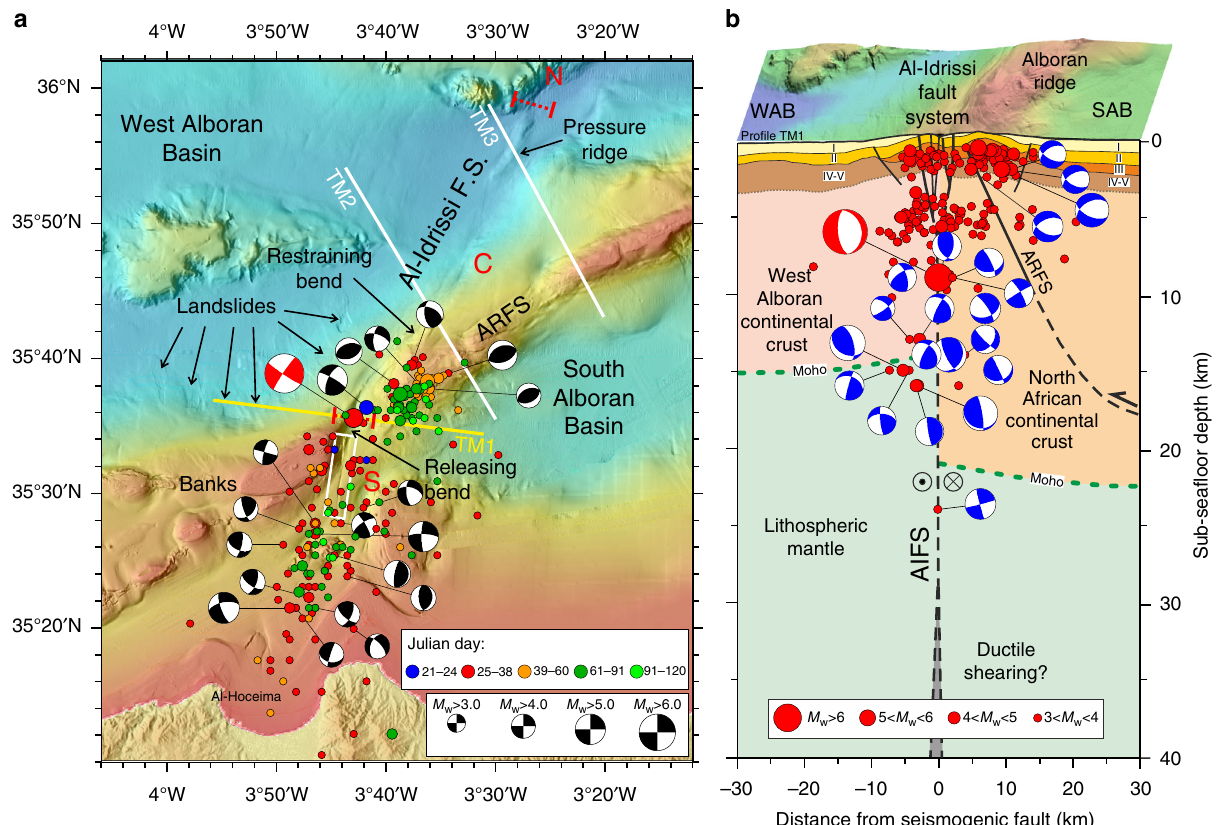
Fig. 5 Aftershock analysis, focal mechanisms and conceptual AIFS section. a Bathymetric map showing relocated aftershocks over time. Focal mechanisms of the 2016 main shock (red), foreshock and aftershocks (black) are included. Pro fi le TM1 is depicted in yellow. The North (N), Central (C) and South (S) segments are located on the map. b Conceptual lithospheric section across pro fi le TM1 with focal mechanism of the mainshock (red) and aftershocks (blue). Focal mechanisms have been projected onto the vertical plane of the focal sphere. Earthquake hypocentres (red dots) of M w 3 – 6.4 are projected within ±30 km of pro fi le TM1. Faults and structure of the Moroccan Margin are shown. ARFS: Alboran Ridge Fault System, WAB: West Alboran Basin,